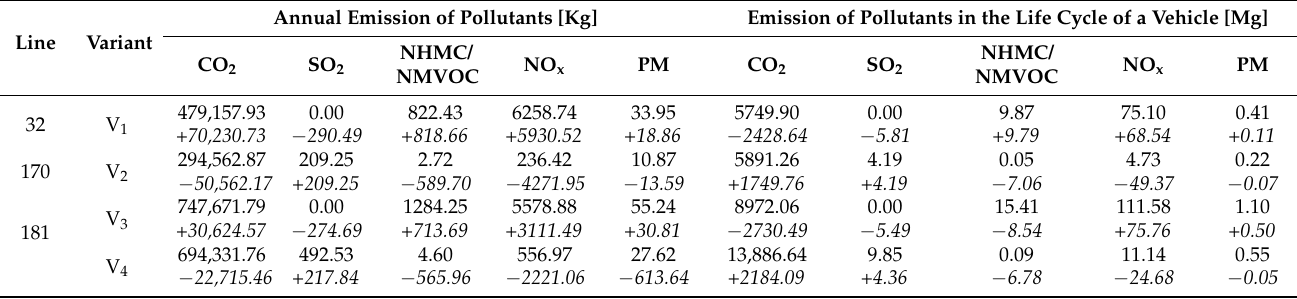
Table 2. Simulations of the annual emissions of pollutants from public transport and emissions in the life cycle of vehicles on the tested lines in different variants and their comparison with the emissions generated in the current operation.